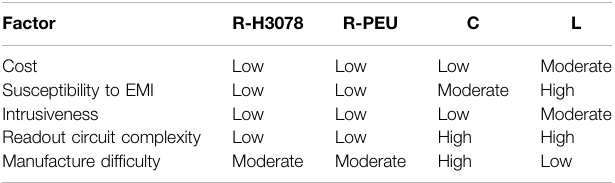
TABLE 3 | Ranking of sensors by their relative performance on several qualitative